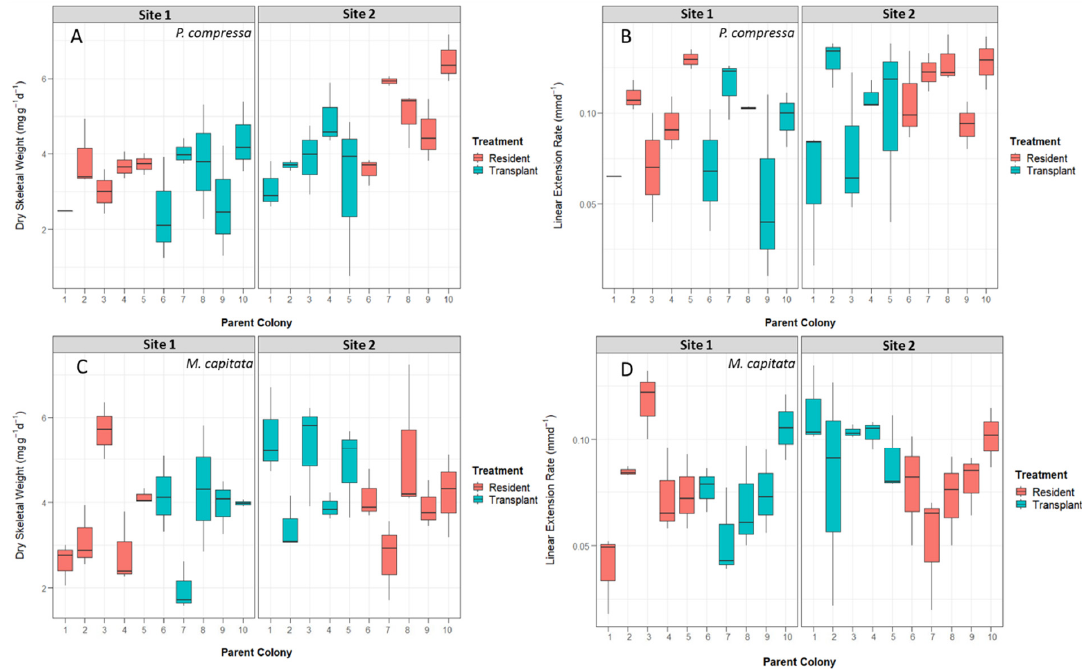
Figure 4. Boxplots of calcification rates by parent colony and treatment across both Site 1 and Site 2. ( A ) Dry skeletal weight for P. compressa separated by destination site number and parent colony. ( B ) Dry skeletal weight for M. capitata separated by destination site number and parent colony. ( C ) Linear extension rates for P. compressa separated by destination site number and parent colony. ( D ) Linear extension rates for M. capitata separated by destination site number and parent colony. The bold line in each box represents medians, and box limits represent the 25th to 75th percentiles of the data. Whiskers extend to data points that are less than 1.5 times the interquartile range away from 1st or 3rd quartile.